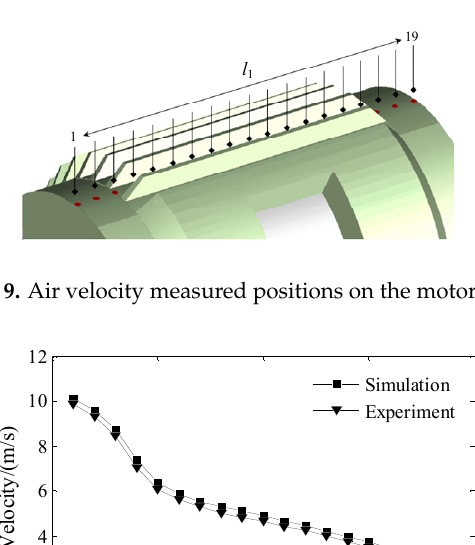
Figure 8. 3D fluid field distribution on the shell surface of the motor.